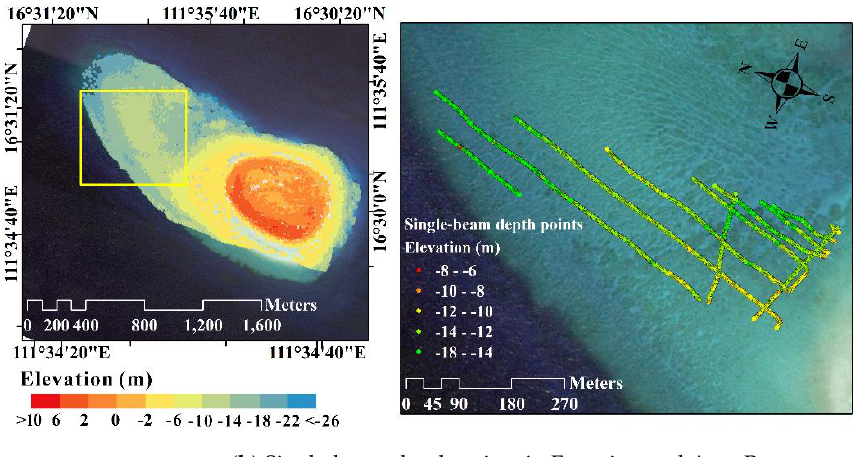
Figure 20. The distribution of the single-beam depth points in the experimental areas.